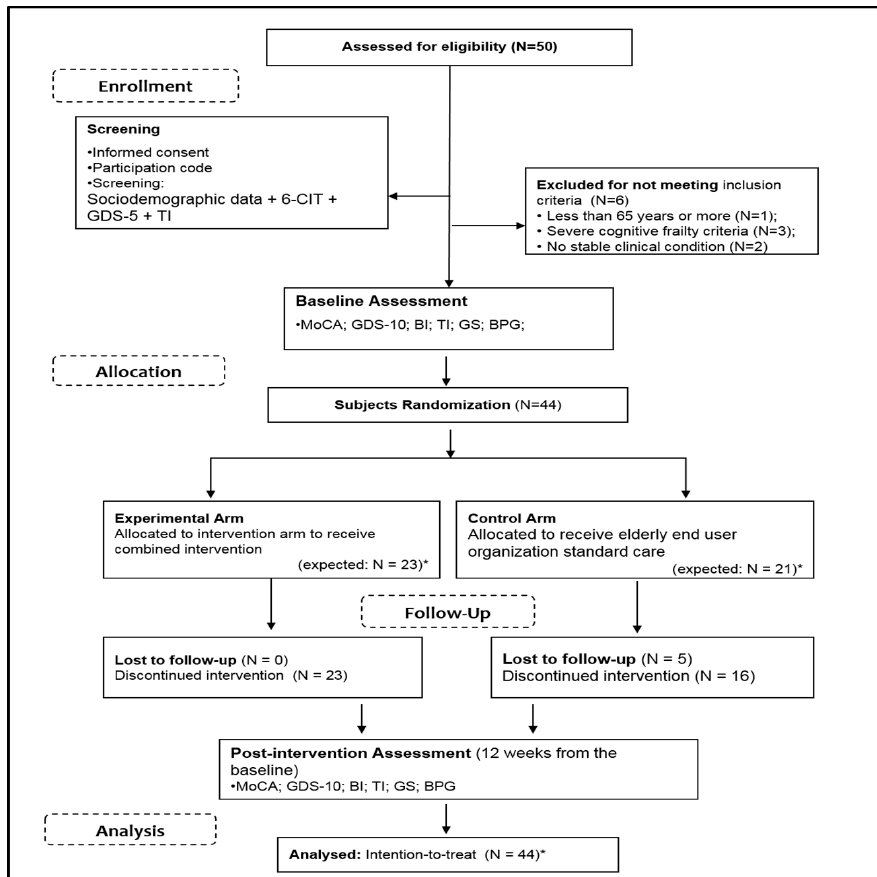
Figure 1. Consolidated standards of reporting clinical Trial (CONSORT) flow chart related to data collection. Note: 6-CIT—Six Item Cognitive Test; GDS-5—Geriatric Depression Scale with 5